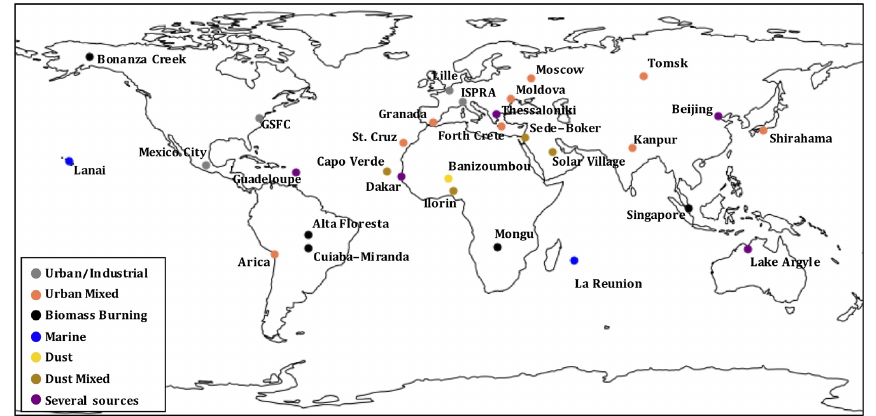
Figure 1. Geographical distribution of the AERONET sites considered in the analyses. The color of each site locator is assigned according to the aerosol type of the site (see sixth column in Table 1). Table 1. General description of the data used in the validation study. The first two columns present the name of the site and the period with τ measurements. The third column shows the total number of τ measurements. The two following columns contain the average values of τ( 440 ) and the Ångström exponent. The last two columns illustrate the aerosol type and the main references analyzing the site characteristics. Site